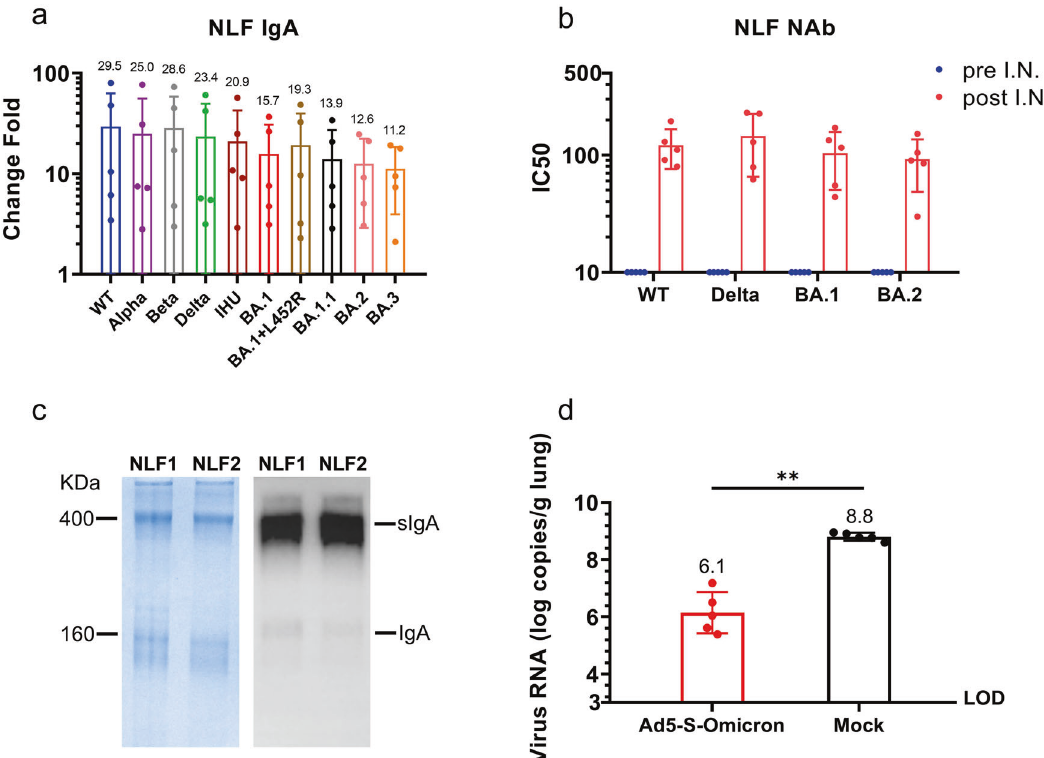
Fig. 3 Detection of spike-speci fi c secretory IgA and neutralizing activities in human nasal lavage fl uids (NLFs). a Detection of secretory IgA that binds to spikes of Wildtype, Alpha (B.1.1.7), Beta (B.1.351), Delta (B.1.617.2), IHU (B.1.640.2), and Omicron BA.1, BA.2, BA.3, BA.1.1, and BA.1 + L452R in NLFs. NLFs were collected using a nasal irrigator with 40 ml saline before and 4 weeks after intranasal vaccination using 4 × 10 10 vp Ad5-S-Omicron. IgA was measured using MSD panel 25 IgA kit (K15585U, Meso Scale Discovery, USA). A value above 3-fold higher than the baseline is considered seropositive. Data are shown as means ± SD ( n = 5). b Pseudovirus neutralizing antibody titers against Wildtype, Delta, and Omicron BA.1 and BA.2 in concentrated nasal lavage fl uid collected at day 0 and 4 weeks after intranasal spray of 4 × 10 10 vp Ad5-S-Omicron. c Twenty microliters of NLFs from donors #1 (NLF1) and #2 (NLF2) were loaded onto SDS polyacrylamide gels for electrophoresis. Coomassie blue staining of the gel and Western blot analysis using anti-human IgA showed the dominant presence of dimeric IgA with a molecular weight of approximately 400 kDa. d Passive transfer of NLFs to mice conferred protection against the Omicron BA.1.1 challenge. One hundred microliters of concentrated NLFs from either donor #1 (NLF1) or one non-vaccinee were instilled into the nostrils of female 7-week-old BALB/c mice. Four hours later, mice were intranasally challenged with Omicron BA1.1 at 50,000 FFU. Three days later, mice were sacri fi ced and the lungs were collected for quanti fi cation of viral RNA by qPCR. Data are shown as the means ± SD ( n = 5) and were analyzed with an unpaired t test (** P < 0.01). Individual data are presented dimeric and multimeric forms that can provide the fi rst-line Currently, almost all regulatory-approved COVID-19 vaccines blockage against Omicron entry via upper respiratory tract. are administered via intramuscular injection. Although most of We found that the inactivated ancestral vaccine priming has a these vaccines have been shown to reduce severe disease and signi fi cant impact on the mucosal IgA antibody response. Without mortality, they are not highly effective in completely blocking inactivated vaccine priming, intranasal Ad5-S-Omicron only infection of Omicron subvariants, which evolve to preferentially increased IgA and neutralizing antibodies against Omicron in infect and replicate in the upper respiratory pathway, especially BALFs and sera but not pre-Omicron strains Wildtype, Beta, and the nose. 19 Vaccine effectiveness also wanes rapidly, usually in Delta. With inactivated vaccine priming, intranasal Ad5-S-Omicron less than 6 months. 12 It has been reported that the best elevated IgA and neutralizing antibodies against not only Omicron protection comes from people with “ hybrid immunity ” , i.e., who but also pre-Omicron strains in BALFs. This suggested that have both infection and vaccinations. The effectiveness against inactivated vaccine-primed memory B cells that cross-react with Omicron symptomatic infection increased from 52.2% in people Omicron spike may further proliferate after intranasal Ad5-S- with 3 doses of mRNA vaccines to 77.3% in people with “ hybrid Omicron boost and home in the respiratory tract. Therefore, immunity ” , i.e., 3 doses of mRNA vaccines plus an infection intranasal Ad5-S-Omicron on the basis of inactivated ancestral before the Omicron pandemic. 20 A key difference between vaccine led to induction of broadly mucosal and systemic SARS-CoV-2 infection-induced immunity and intramuscular neutralizing antibodies. Of note, we observed a somewhat lower vaccination-induced immunity is that natural infection induces level of BALF IgA for Omicron BA.1 spike than for Wildtype spike, respiratory mucosal immunity. An important hallmark of whereas neutralizing titer against BA.1 was higher than that mucosal immunity is the production of antigen-speci fi c against the Wildtype spike. This is probably due to the presence of secretory IgA antibodies. Several studies have reported that common non-neutralizing epitopes among different spike pro- spike-speci fi c mucosal IgA in bronchoalveolar lavages, saliva, or teins or the presence of more IgA-binding epitopes in the nasal swabs can be detected in people who have recovered Wildtype spike. Intranasal booster using Ad5-S-Omicron not only from SARS-CoV-2 infection. 21 – 23 Unlike monomeric serum IgA, stimulated new B cells producing Omicron-speci fi c antibodies but mucosal secretory IgA is produced locally and is present in